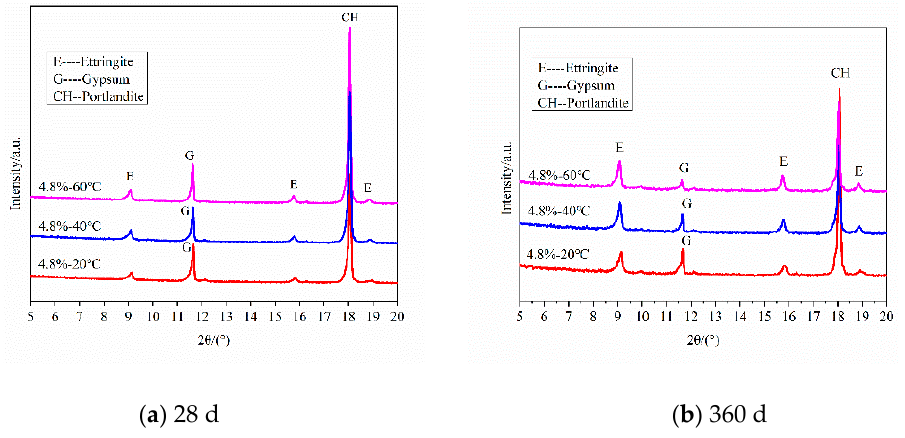
Figure 6. XRD patterns of mortars added with 4.8% SO 3 in aggregate at different curing temperatures.